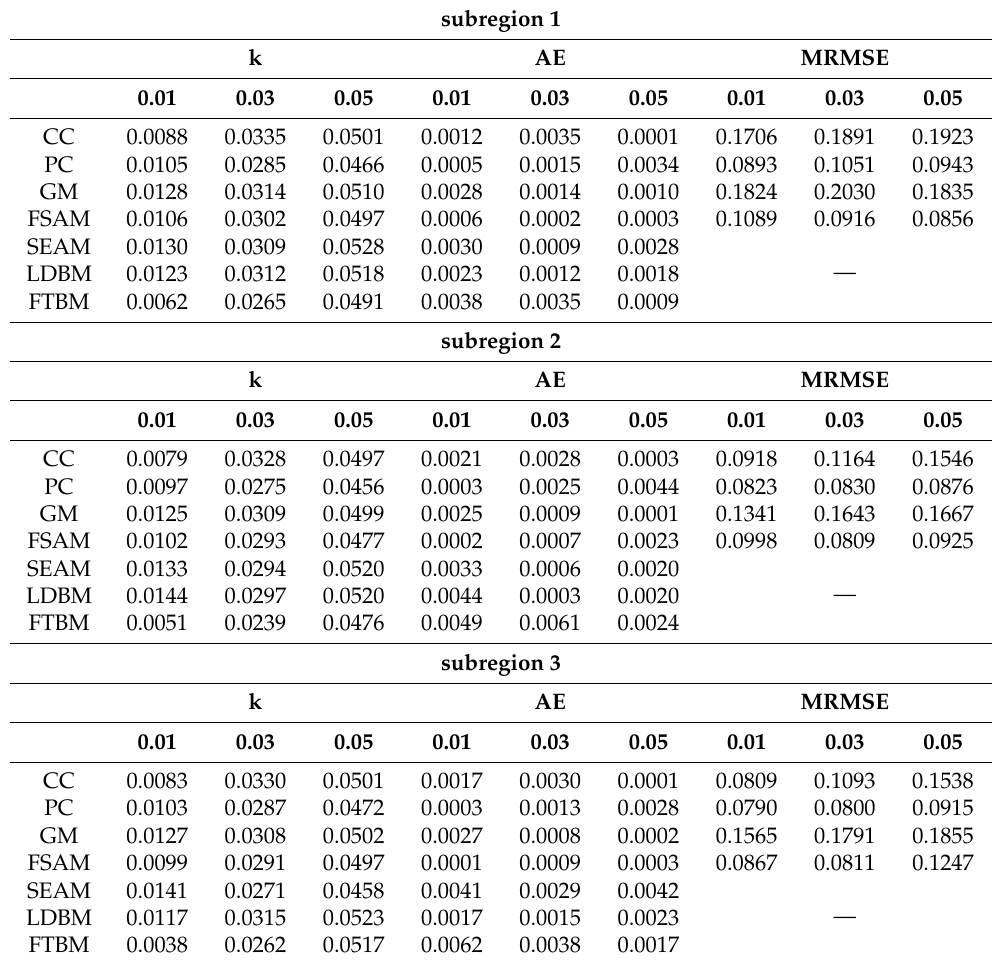
Table 2. The results of all test methods on subregion 1, subregion 2, and subregion 3 with spatial resolution of 1 m.